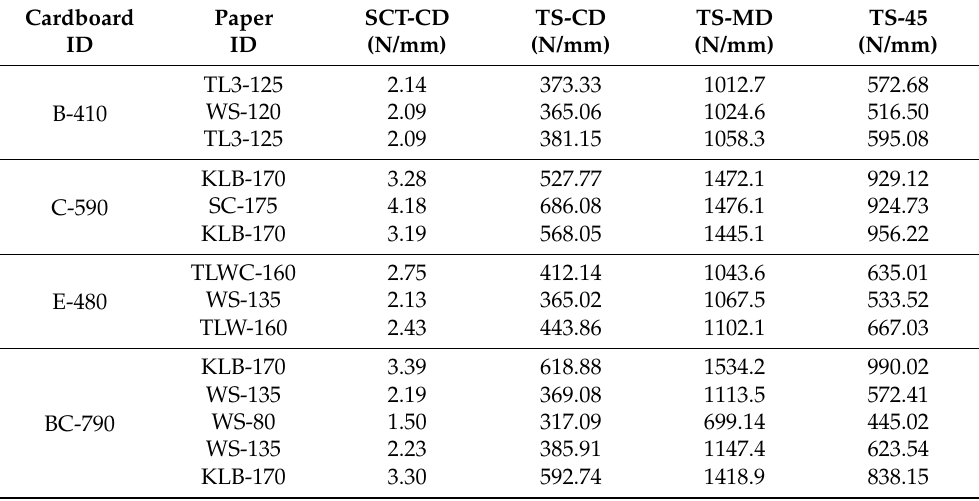
Table 4. Average SCT values in CD and average tensile stiffness values of all constituent papers in the MD, CD and in 45 degree